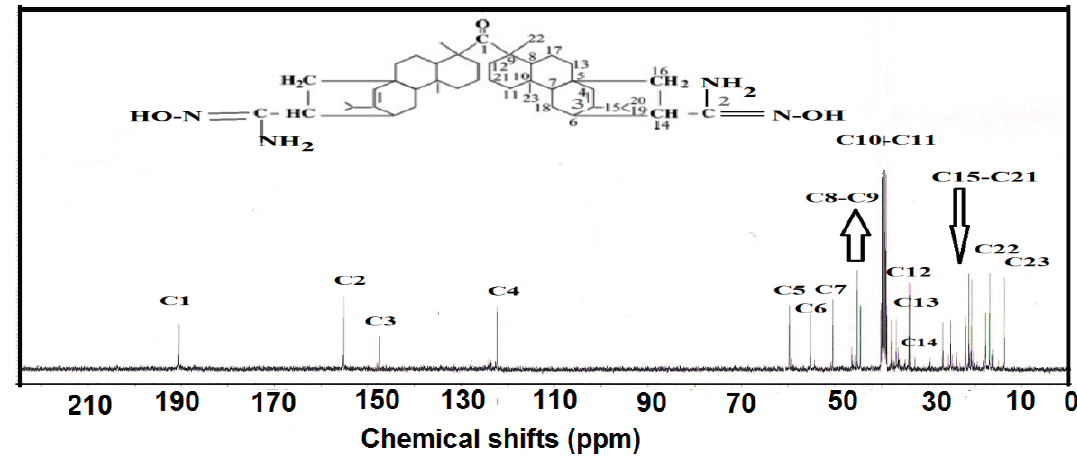
Figure 3. 13 C NMR spectrum of RK-AN